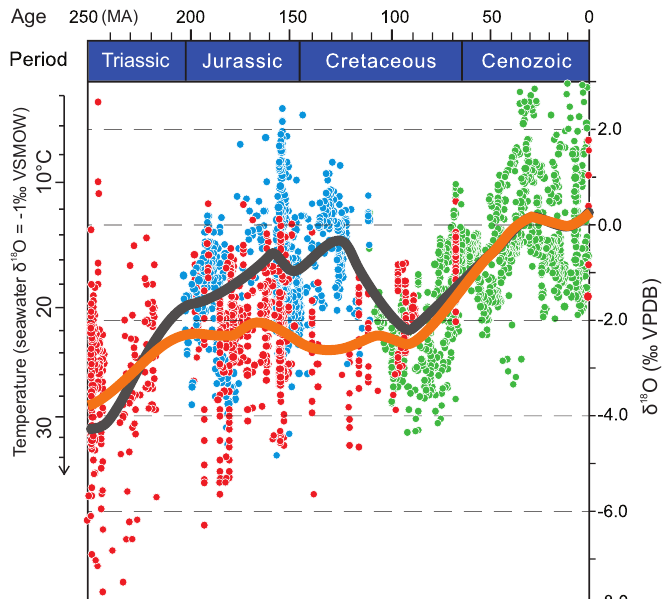
Figure 9. Evolution of published Mesozoic–Cenozoic δ 18 O values. Brachiopod data (red circles), belemnite data (blue circles), planktic foraminifera (green circles). Smoothed curves for all data (dark grey curve) and brachiopod-foraminifera only data (orange curve). The orange curve devoid of belemnite data shows a prolonged warm period during the Jurassic and the Cretaceous (after Price et al. [250], modified). The temperature scale depicted for comparative purposes is based on Anderson and Arthur’s [8] equation and the assumed average oxygen isotope composition for the non-glacial